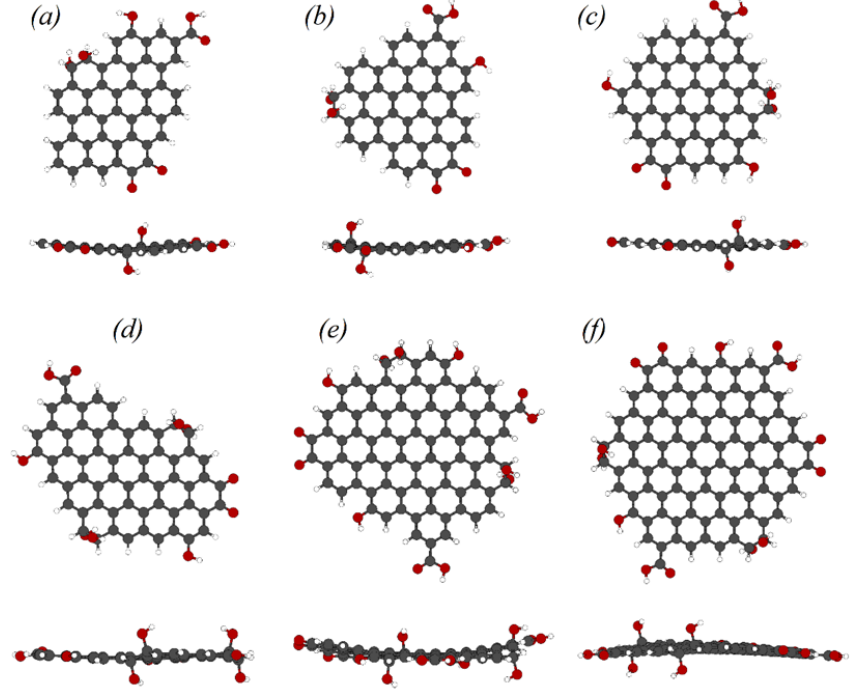
Figure 1. Atomistic models of oxidized graphene sheets: ( a )-C 47 H 18 O 7 , ( b )-C 49 H 18 O 7 , ( c )-C 55 H 18 O 8 , ( d )-C 61 H 22 O 10 , ( e )-C 84 H 26 O 13 , ( f )-C 98 H 24 O 14 .